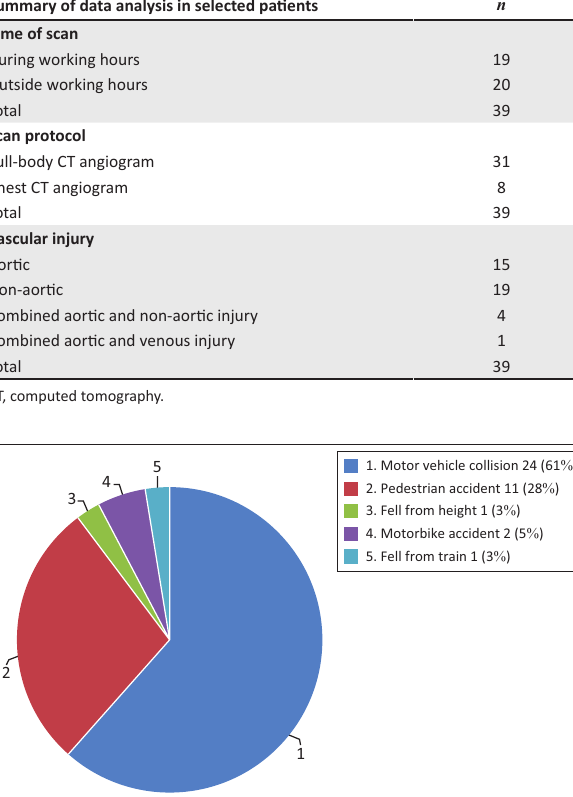
TABLE 1: Computed tomography scan protocol and types of vascular injury. Summary of data analysis in selected patients